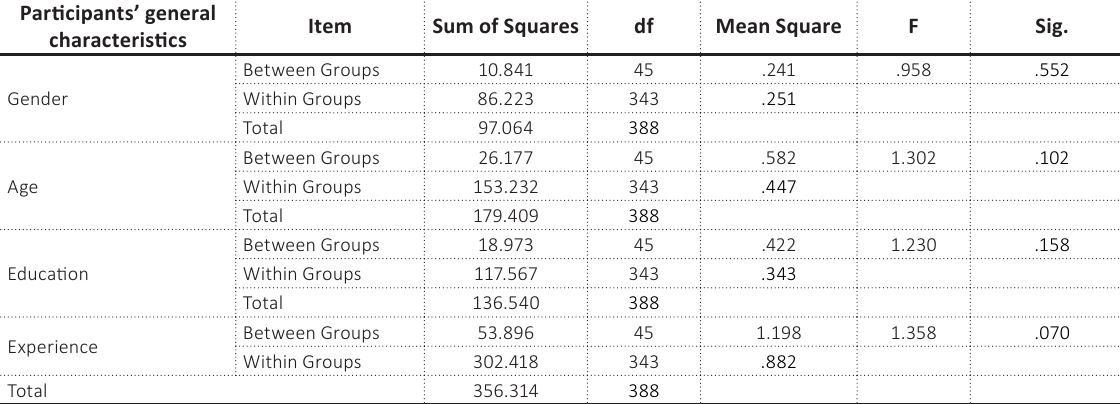
Table 4. ANOVA test Participants’ general